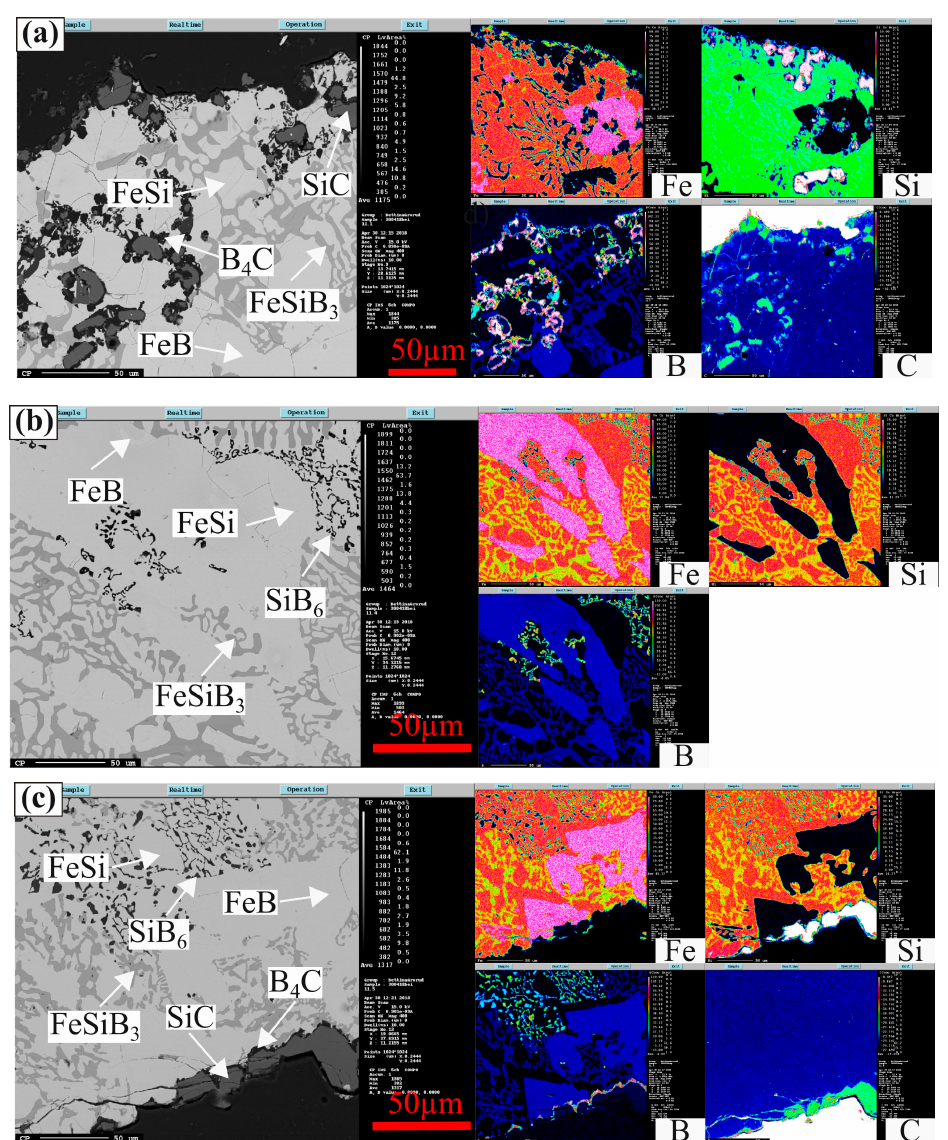
Figure 9. EPMA images of Fe-26.38Si-9.35B alloy after two times melting/solidification cycles at 1157 ± 20 °C: ( a ) at the top, ( b ) at the center, and ( c ) at the bottom. All phases in the samples after thermal cycles were analyzed by WDS in EPMA, and each phase was measured at least twenty points in the samples, the chemical component of FeSi, FeSiB 3 , FeB, and SiB 6 are summarized in Table 5. Table 5. Fe, Si, and B contents in FeSi, FeSiB 3 , FeB, and SiB 6 phases measured with WDS (at %). Phase